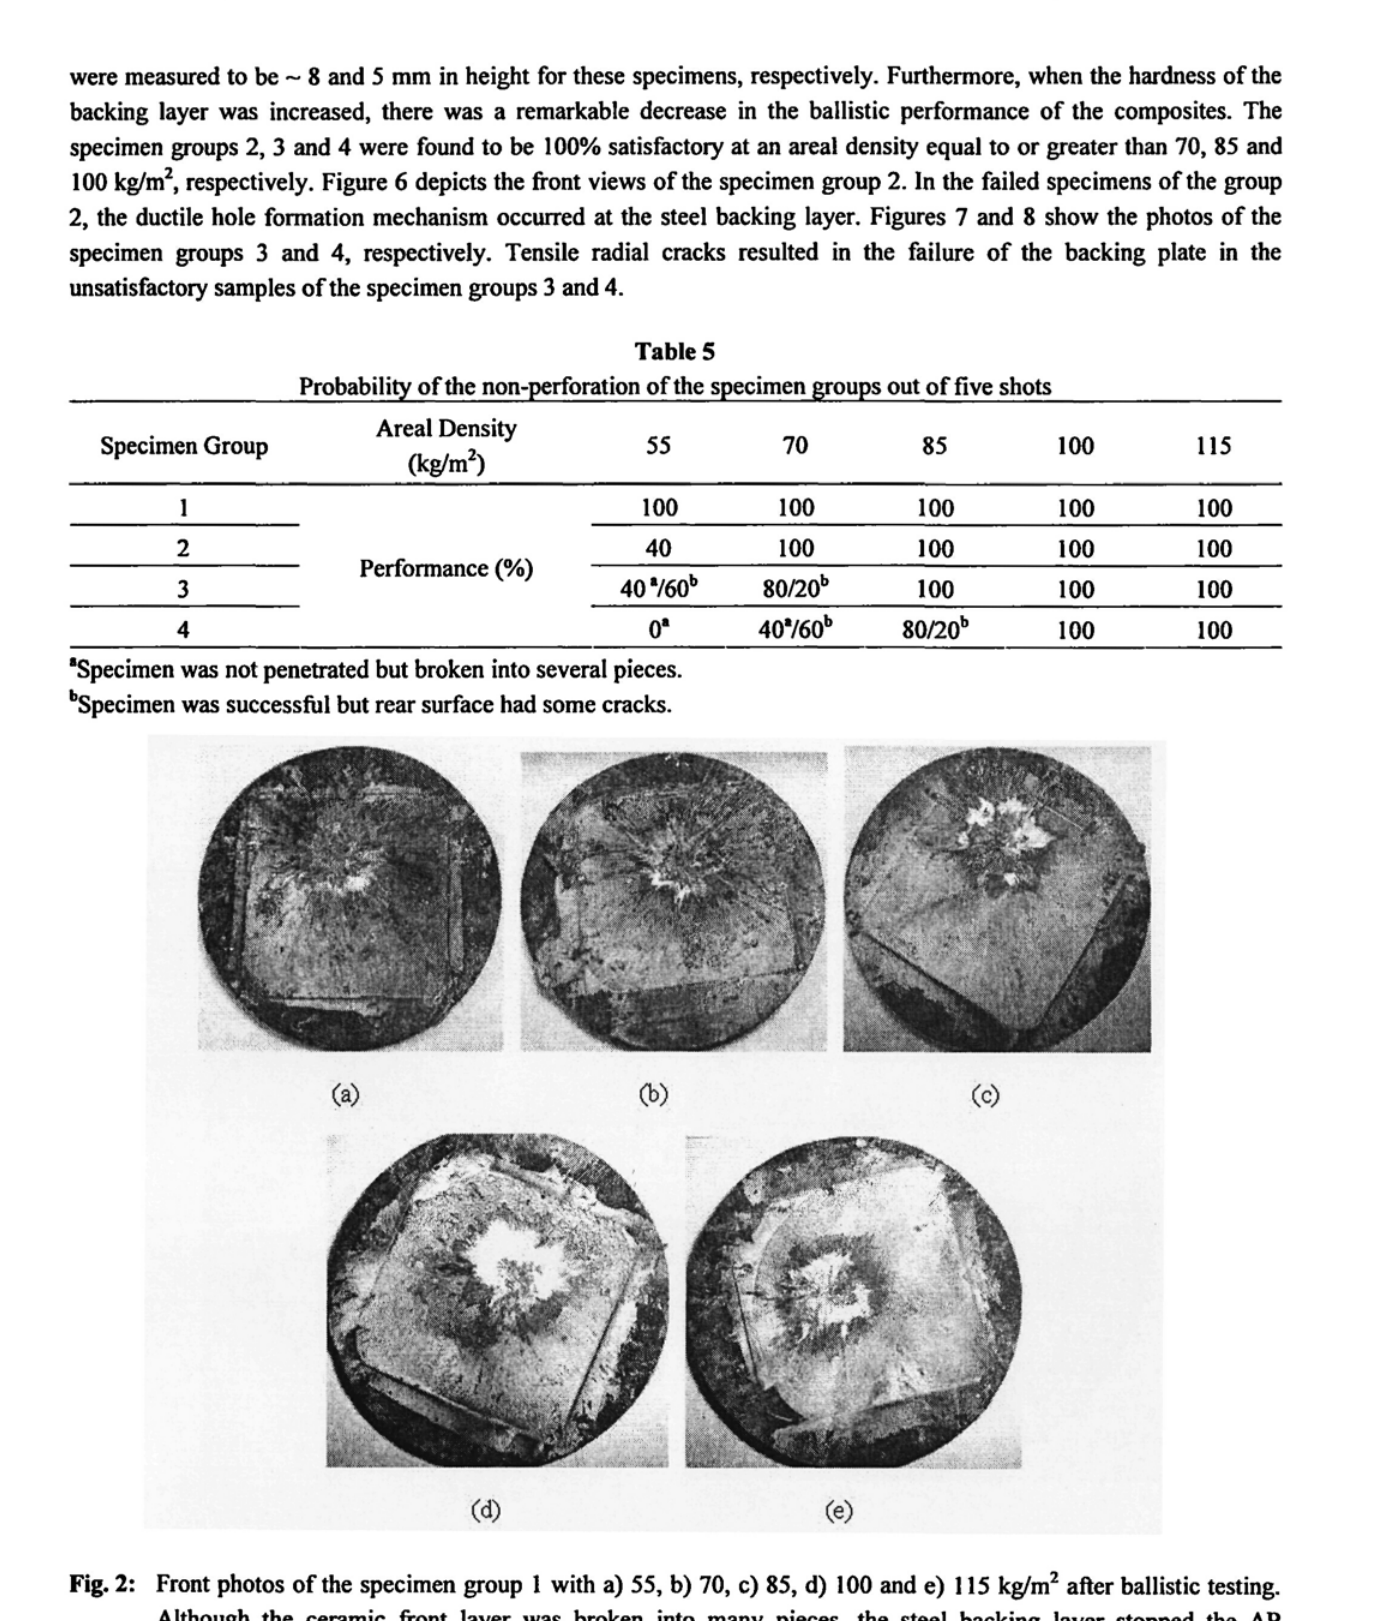
Fig. 2: Front photos of the specimen group 1 with a) 55, b) 70, c) 85, d) 100 and e) 115 kg/m 2 after ballistic